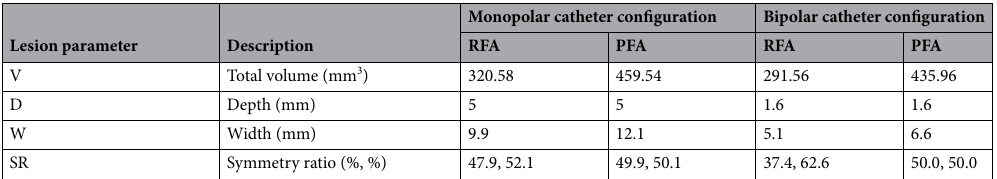
Table 1. Total volume (V), depth (D), width (W) and symmetry ratio (SR) of the lesions for the reference models displayed in Fig. 2. The width (W) in the bipolar catheter configuration was assessed as the width of the lesion in the transversal section